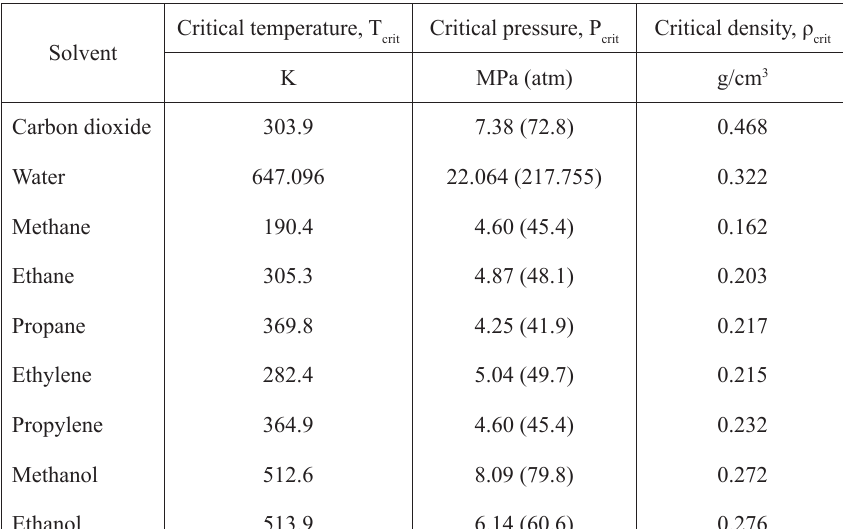
Table 2. Critical parameters of various